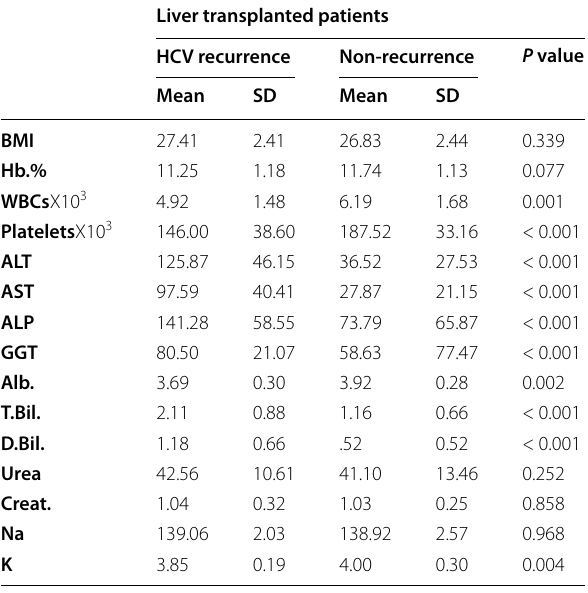
Table 5 Biochemical parameters of the 106 recipients post-OLT